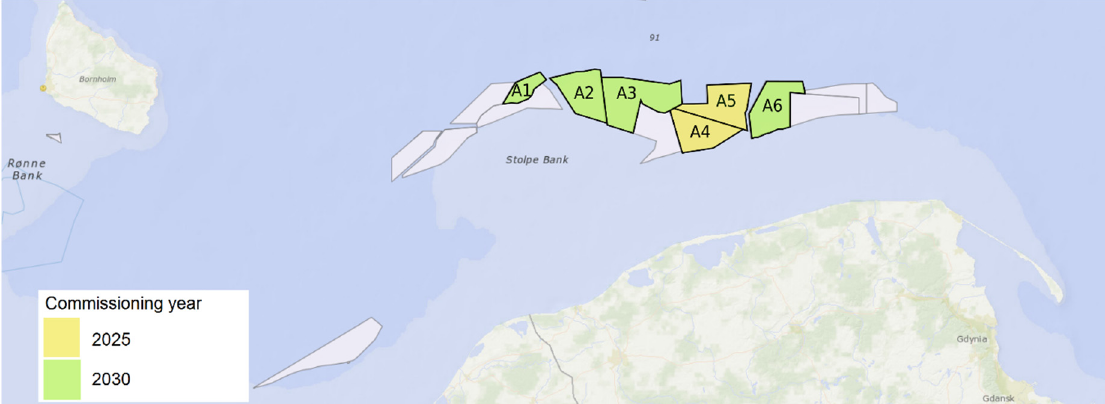
Figure 2. Decision-making alternatives in the assessment of planned offshore wind farms: A1–FEW Baltic II (RWE Renewables)–350 MW, A2–Baltic II (Polenergia and Equinor)–1200 MW, A3–Baltica 2 (PGE)–1498 MW, A4–Baltic 3 (Polenergia and Equinor)–600 MW, A5–Baltica 3 (PGE)–1045.5 MW, A6–Baltic Power (PKN Orlen)–1200 MW.